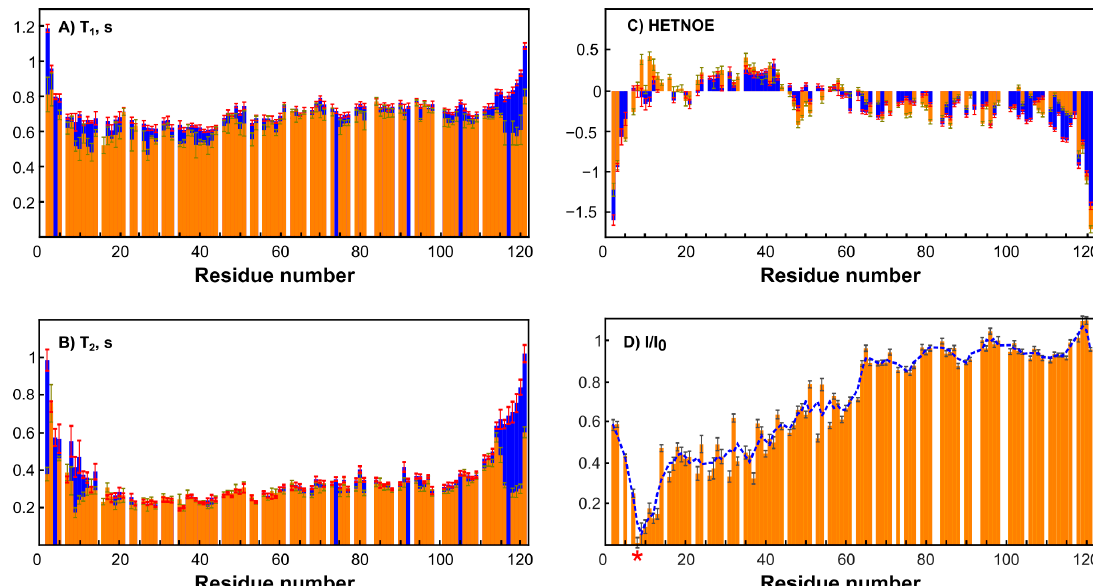
Figure 7. Dynamics and PRE data on RL2 and MTSL-RL2. Error bars represent random noise error of fitting the experimental data. ( A ) A comparison of T 1 values of RL2 at pH 3.5 (blue) and diamagnetic MTSL-RL2 (orange). ( B ) The comparison of T 2 -values of RL2 at pH 3.5 (blue) and diamagnetic MTSL-RL2 (orange). ( C ) A comparison of hetero NOE values of RL2 at pH 3.5 (blue) and diamagnetic MTSL-RL2 (orange). ( D ) Integral ratios of peaks in the HSQC paramagnetic and diamagnetic spectra of MTSL-RL2. The blue dashed curve is a three-point moving window average for the best trend view. The asterisk indicates the MTSL-label site (Cys8).